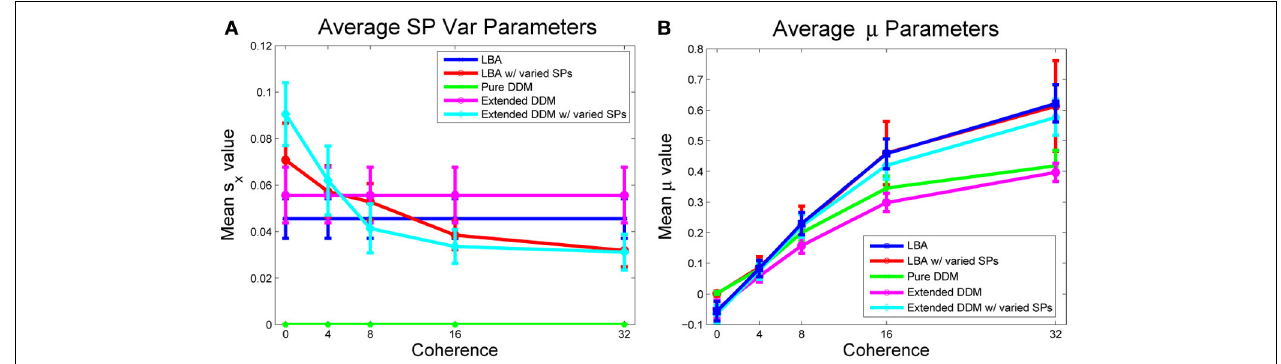
rate μ , averaged over all participants. For LBA model fits, the relative evidence μ 1 − 1 2 in favor of option 1 is shown. Bars indicate standard errors for n = 17